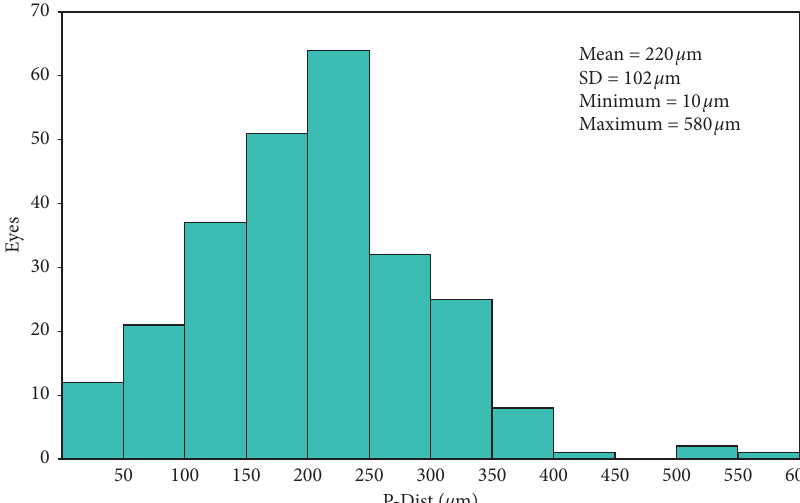
Figure 1: Decentration of the P-Dist (distance between the pupil center and the coaxially sighted corneal light reflex).